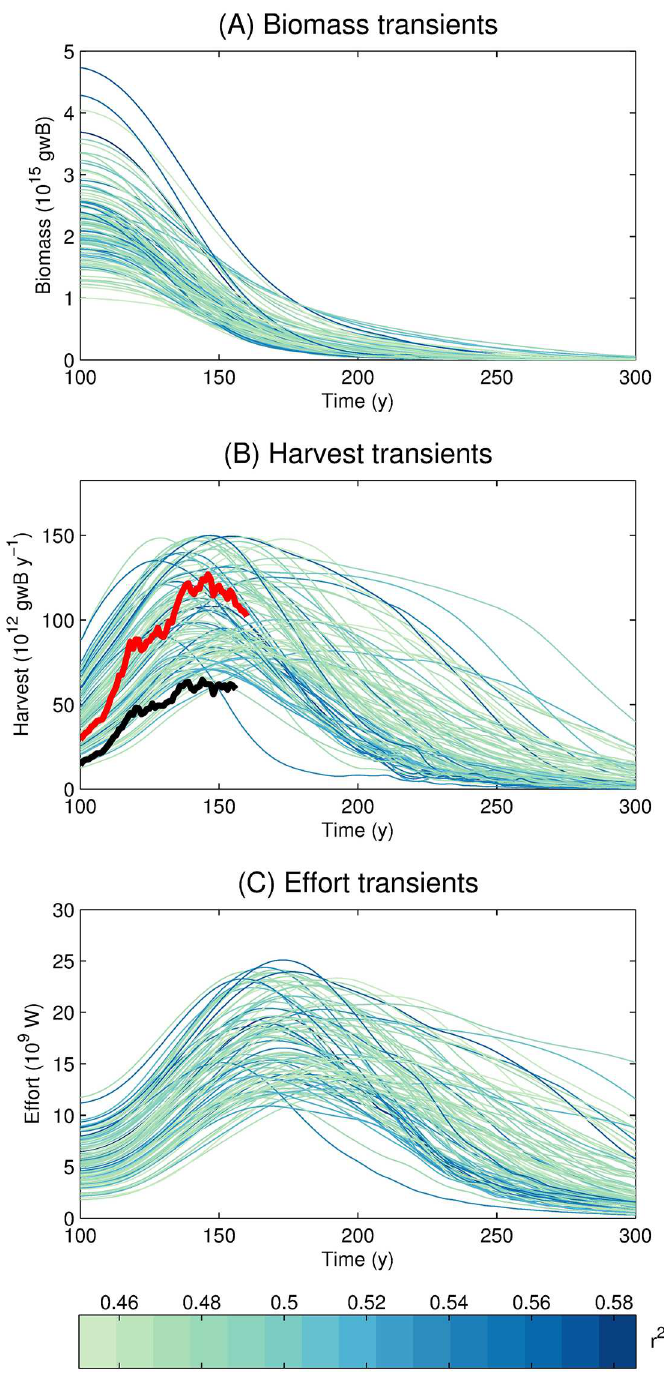
Fig 5. Total (A) biomass, (B) harvest, and (C) effort over all LMEs for the optimized Monte Carlo transient simulations. Line colors represent,for each optimizedensemblemember i , the Pearson r 2 of the H sim area-specific BOATS harvest at each LME l ( ) and the peak harvest of each LME basedon the SAUP i ; l LMEmax H obs ( ). Black [60, 61] and red [71] lines in (B) correspondto two versions of the reconstructed SAUP l LMEmax harvest, assumingthat the year 1950 of the SAUP harvest correspondsto the time in our transient simulations when catchabilitybeginsto